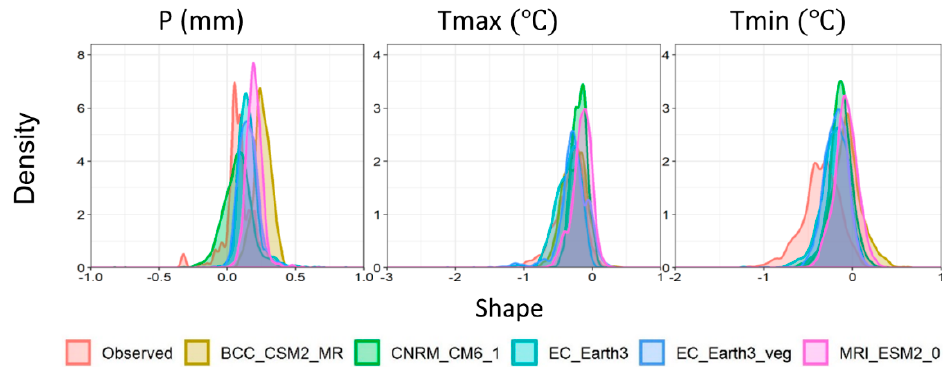
Figure 8. Kernel density curves of the tail index (shape parameter) of P, Tmax, and Tmin extremes for the 1983–2014 period.